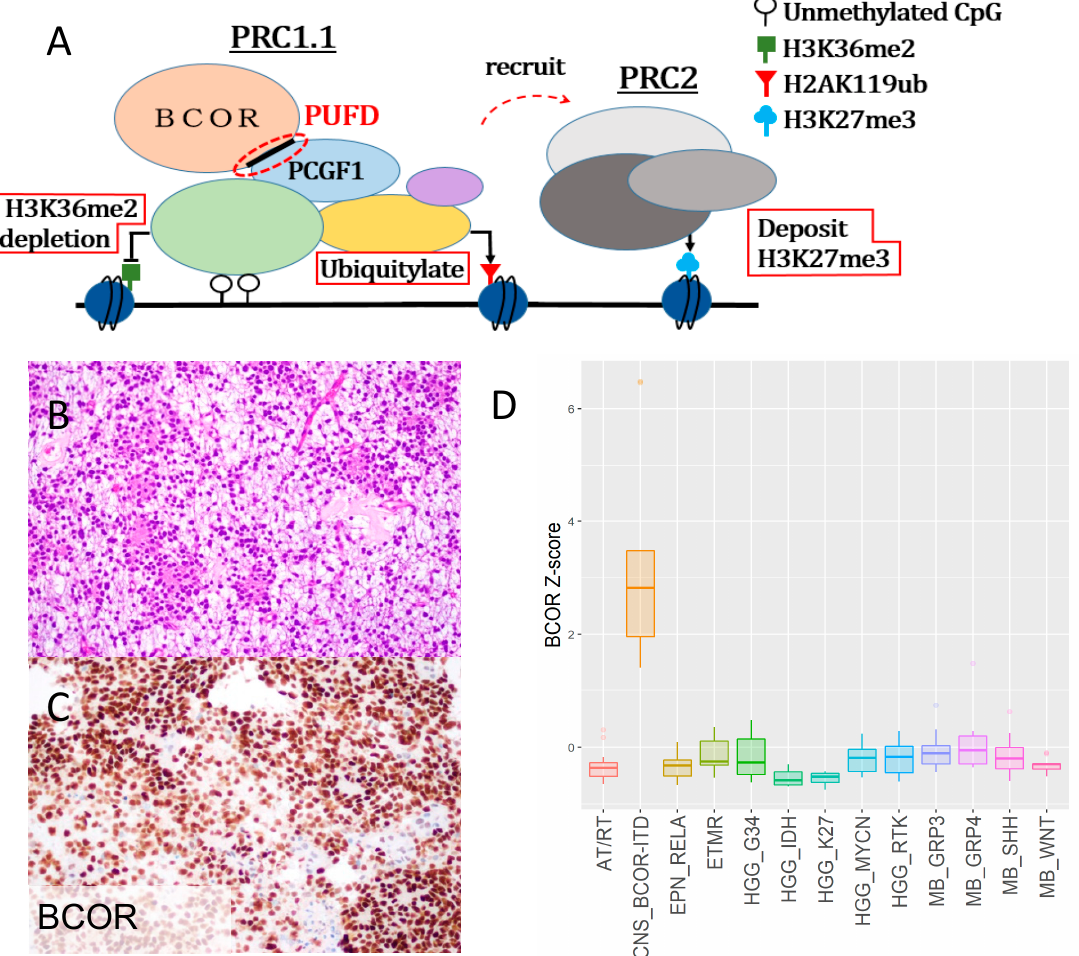
Figure 1. CNS-BCOR ITD is an aggressive tumor with mutant-BCOR overexpression. ( A ) Working model for epigenetic modulation of transcription by the BCOR-PRC1.1 complex, integrating published data on the PRC1.1 and PRC2 complexes. ( B ) A typical histologic appearance of CNS-BCOR ITD. ( C ). Neoplastic cells are diffusely and strongly positive for BCOR. ( D ) BCOR mRNA levels in a range of primary CNS tumor types from public data, including AT/RT (atypical teratoid rhabdoid tumor), EPN_RELA (RELA-fusion positive ependymoma), ETMR (embryonal tumor with multilayered rosettes), HGG_G34 (high-grade glioma with H3 G34 mutation), HGG_IDH (high-grade glioma with IDH1/2 mutation), HGG_K27 (high-grade glioma with H3 K27M mutation, HGG_MYCN (high-grade glioma with MYCN amplification), HGG_RTK (high-grade glioma driven by receptor tyrosine kinases), MB_GRP3 (group 3 medulloblastoma), MB_GRP4 (group 4 medulloblastoma), MB_SHH (sonic-hedgehog-activated medulloblastoma), MB_WNT (WNT-activated medulloblastoma). We confirmed significant upregulation in CNS-BCOR ITD (nine samples) compared to other CNS tumor types (12 entities, 131 samples) ( p < 0.0001, Mann–Whitney test).